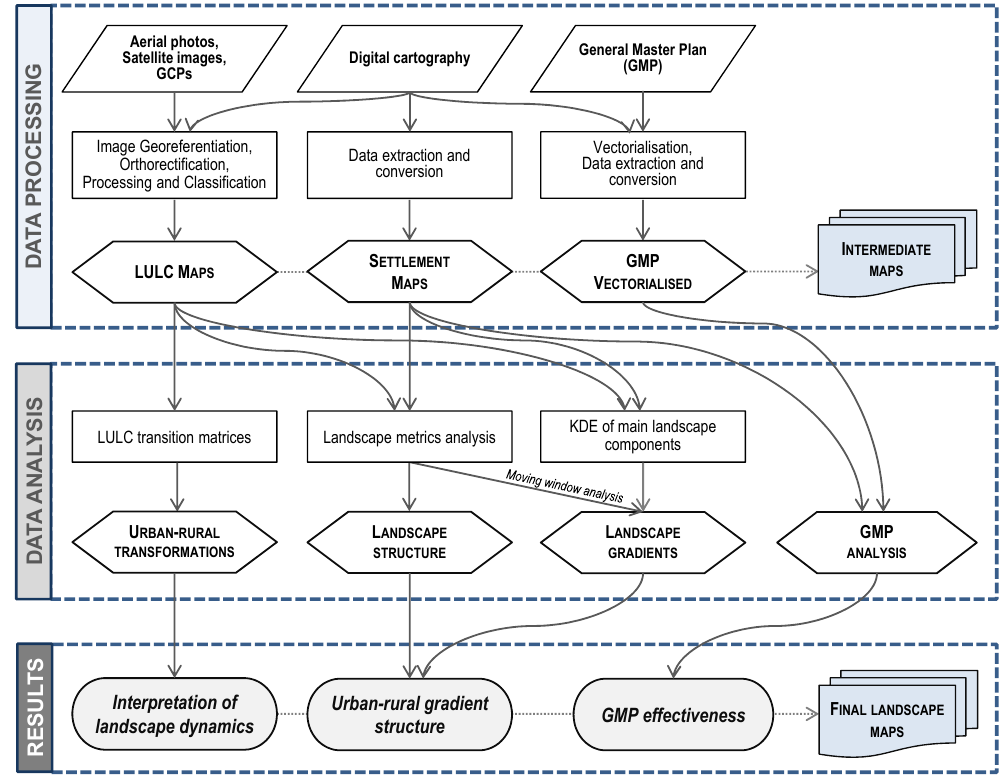
Fig. 1. Flow-chart showing the main methodological phases of the research framework.